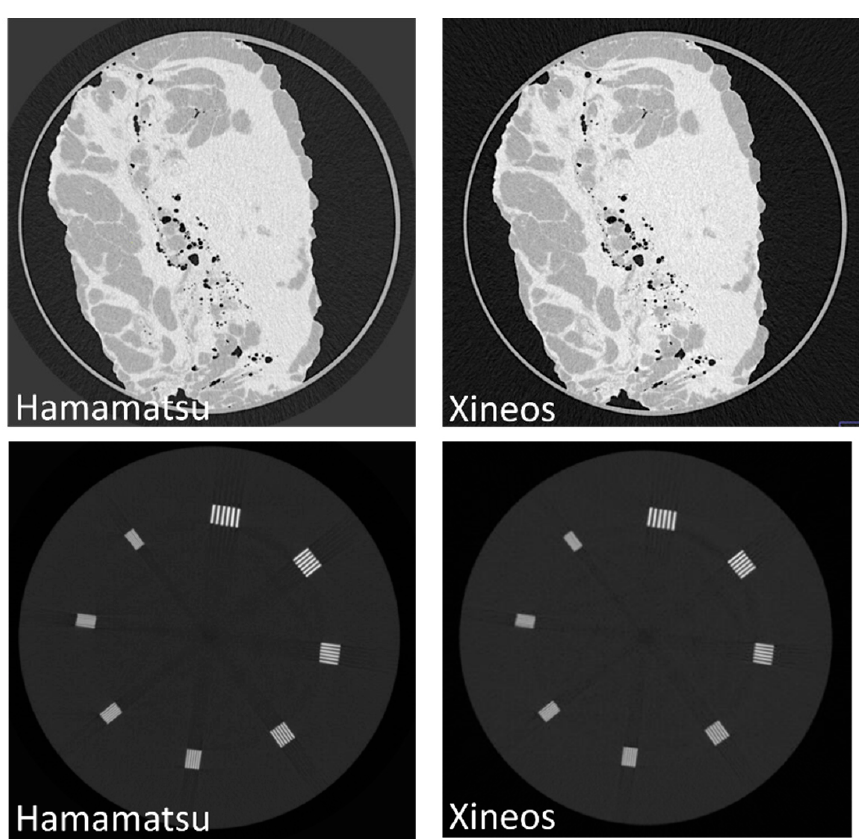
Figure 5. Comparison between images produced by the Hamamatsu ( left column) and the Xineos ( right column) detectors at 32 keV (6 m distance, 4 mGy) of a breast tissue sample inside an 11 cm diameter plastic container ( top row) and a resolution test phantom ( bottom row).